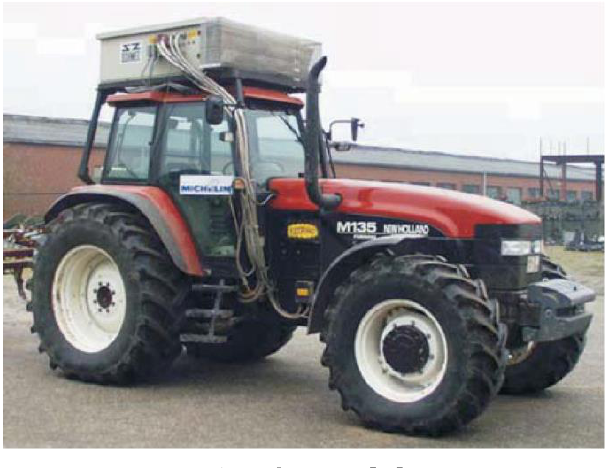
Fig. 6. Caterpillar D7E dozer [21]